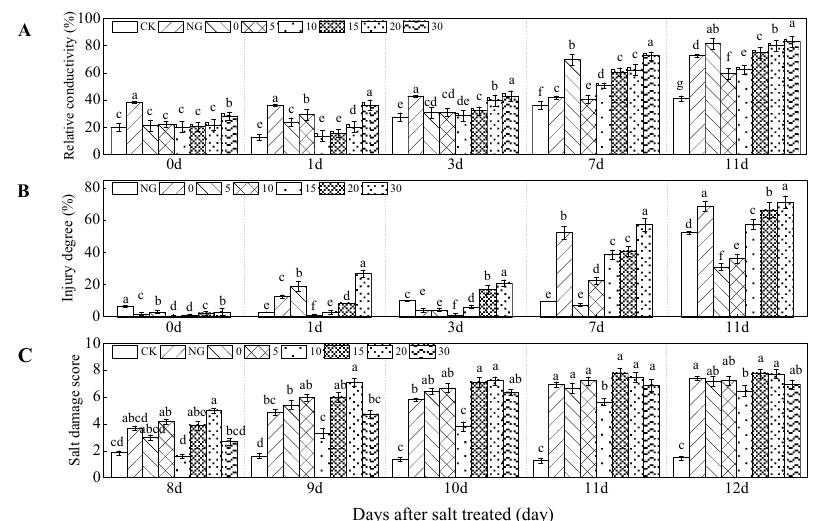
Figure 3. Relative conductivity, injury degree, and salt damage degree of cucumber seedlings as affected by grafting and Ca 2+ treatments under salt stress. Bars represent standard errors. Different letters indicate a significant difference in the same parameter between treatments at p < 0.05.